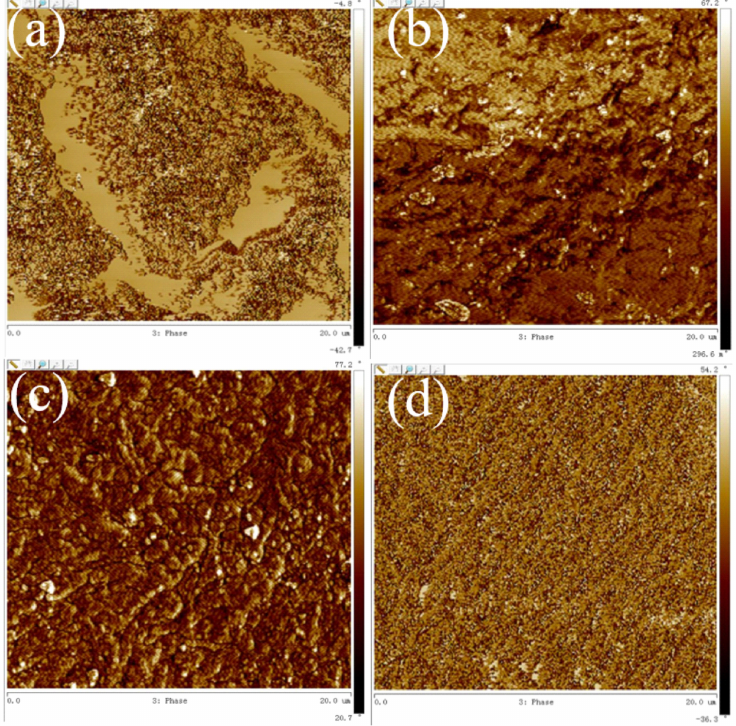
Figure 7. AFM phase images of BWPU 5000 ( a ), BWPU 10,000 ( b ), PWPU 5000 ( c ) and PWPU 10,000 ( d